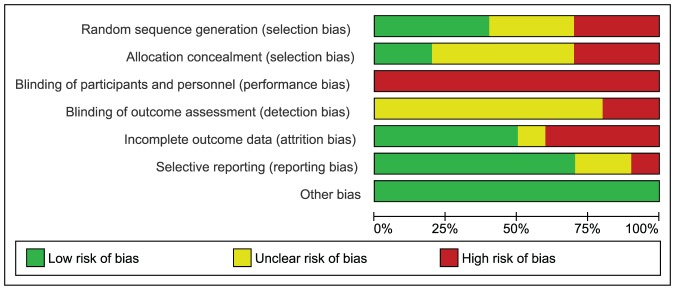
Risk of bias graph